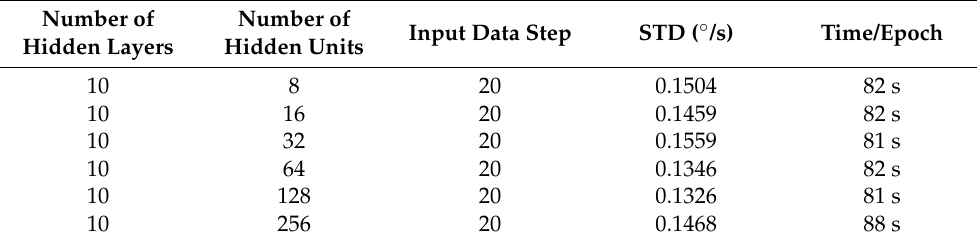
Table 4. Performance with varying values of the number of hidden units.